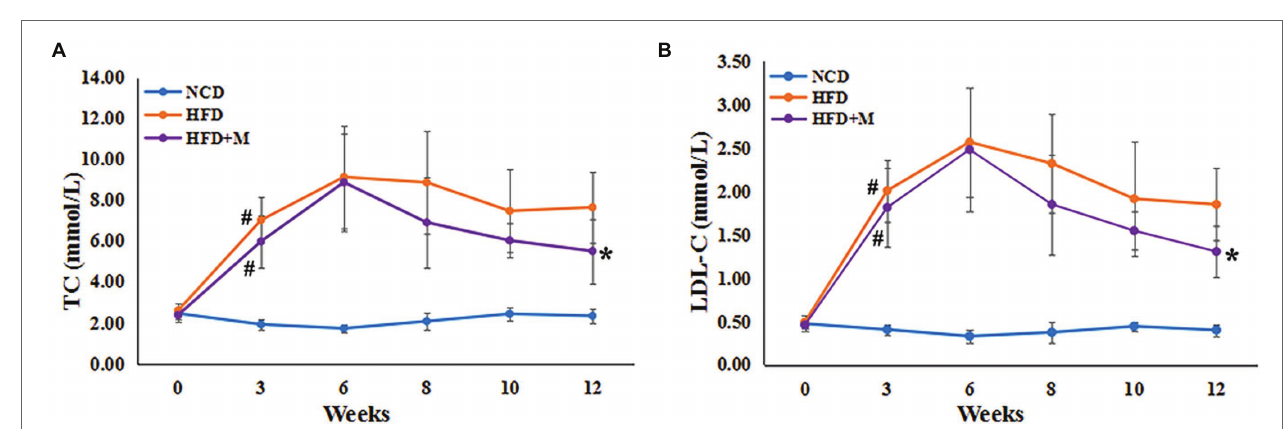
FIGURE 5 | Serum lipids in SD rats following fecal microbiota transplantation from HFD-T monkeys. Serum levels (mmol/L) are shown for (A) total cholesterol (TC), (B) low-density lipoprotein cholesterol (LDL-C). NCD, Normal Chow Diet rats; HFD, HFD rats; HFD + M, HFD rats with transplantation from the fecal microbiota from HFD-T monkeys. # , at Week 3 of HFD feeding, HFD and HFD + M rats vs NCD rats, p < 0.05; *, at Week 12, HFD rats vs HFD + M rats, p <